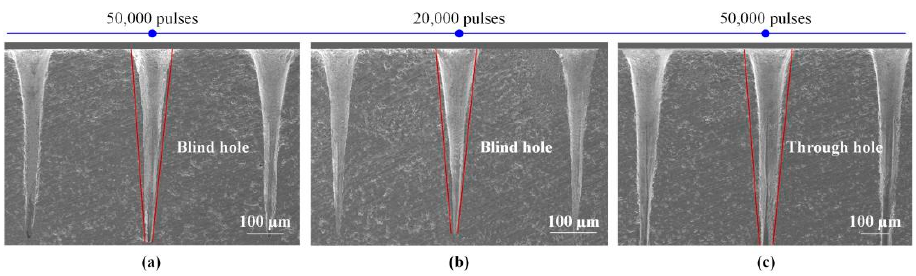
Figure 9. SEM images of holes side-walls in ceramic TBCs. ( a ): Fluence = 4.51 J/cm 2 ( b ): Fluence = 6.06 J/cm 2 ( c ): Fluence = 6.06 J/cm 2.